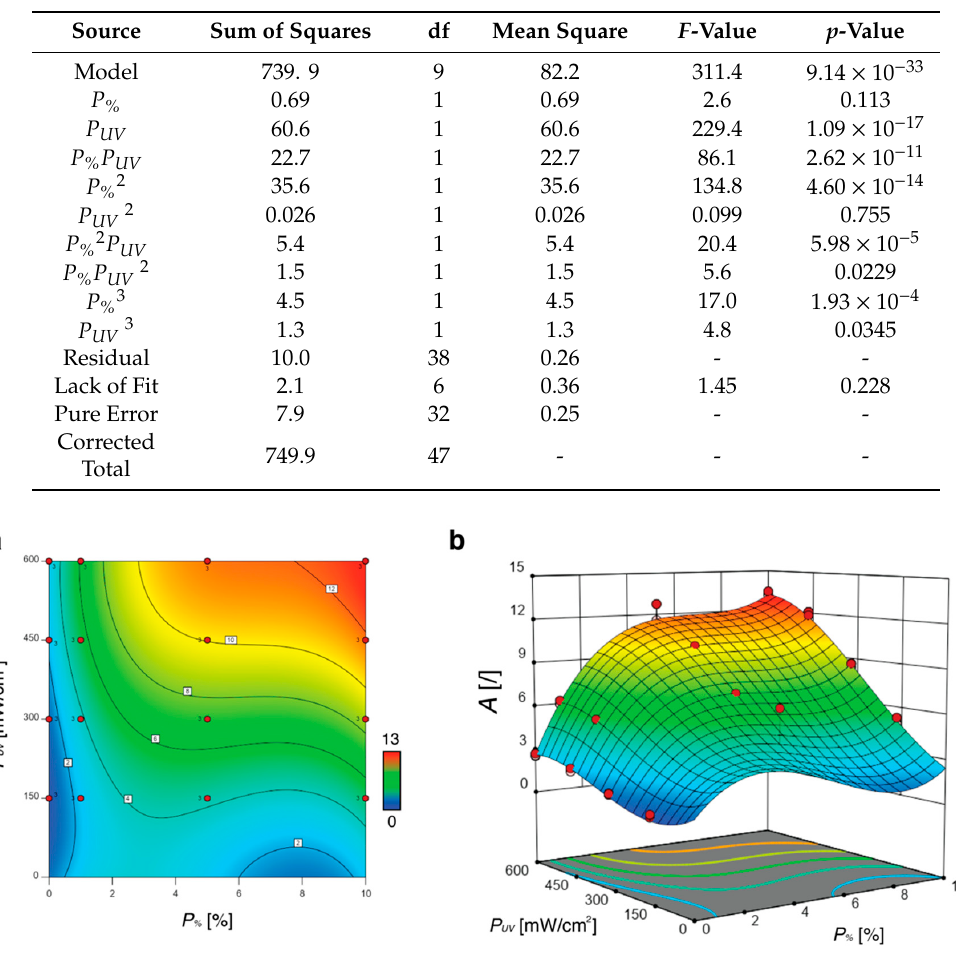
Figure 4. The value A in the photo-bending process, drawn by the reduced cubic model. ( a ) Contour plot in two dimensions (2D) and ( b ) surface plot in three dimensions (3D). The dots represent the experimental points (i.e., the fit of the exponential model) and properly fit with the cubic model proposed in this work.